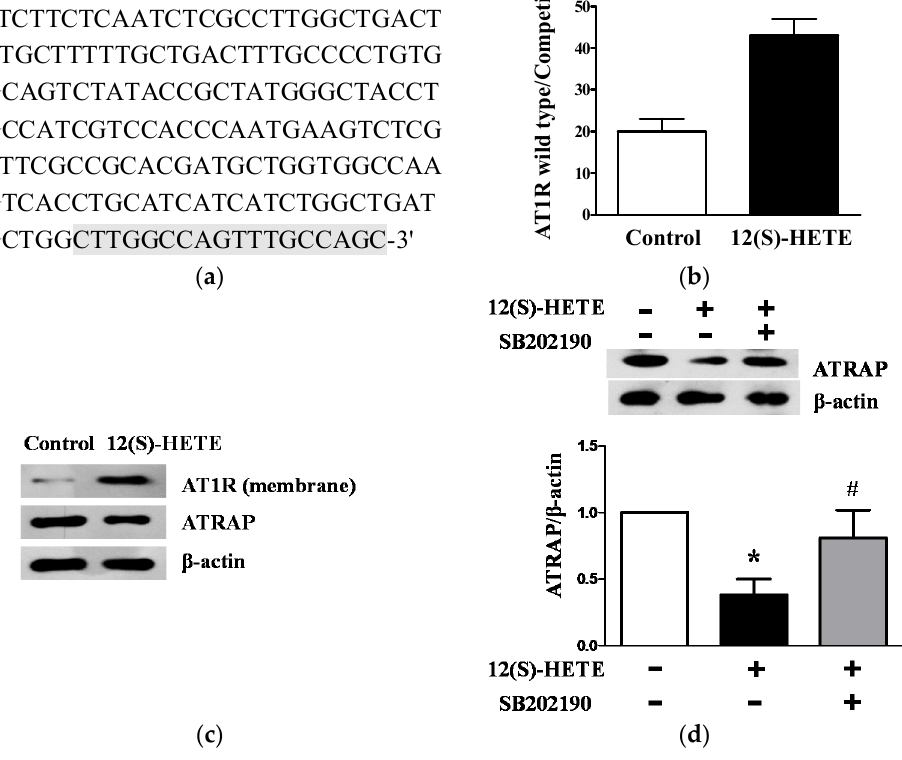
Figure 5. Effect of 12(S)-HETE on AT1R and ATRAP expression in rat glomeruli and MCs. ( a ) The nucleotide sequence of AT1R competitors. The nucleotides used as primers for RT-PCR are indicated by gray boxes; ( b ) Bar graph quantification for glomerular AT1R mRNA expression of control and 12(S)-HETE infusion rats was determined by competitive RT-PCR; n = 10 in each group; ( c ) Glomerular membrane AT1R and ATRAP expression of control and 12(S)-HETE infusion rats was determined by Western blot; n = 10 in each group; ( d ) Rat MCs were stimulated with 12(S)-HETE and/or SB202190, and ATRAP expression was determined by Western blot. Data are presented as the mean ± SD of three independent experiments; * p < 0.01 vs. the control; # p < 0.05 vs. 12(S)-HETE.